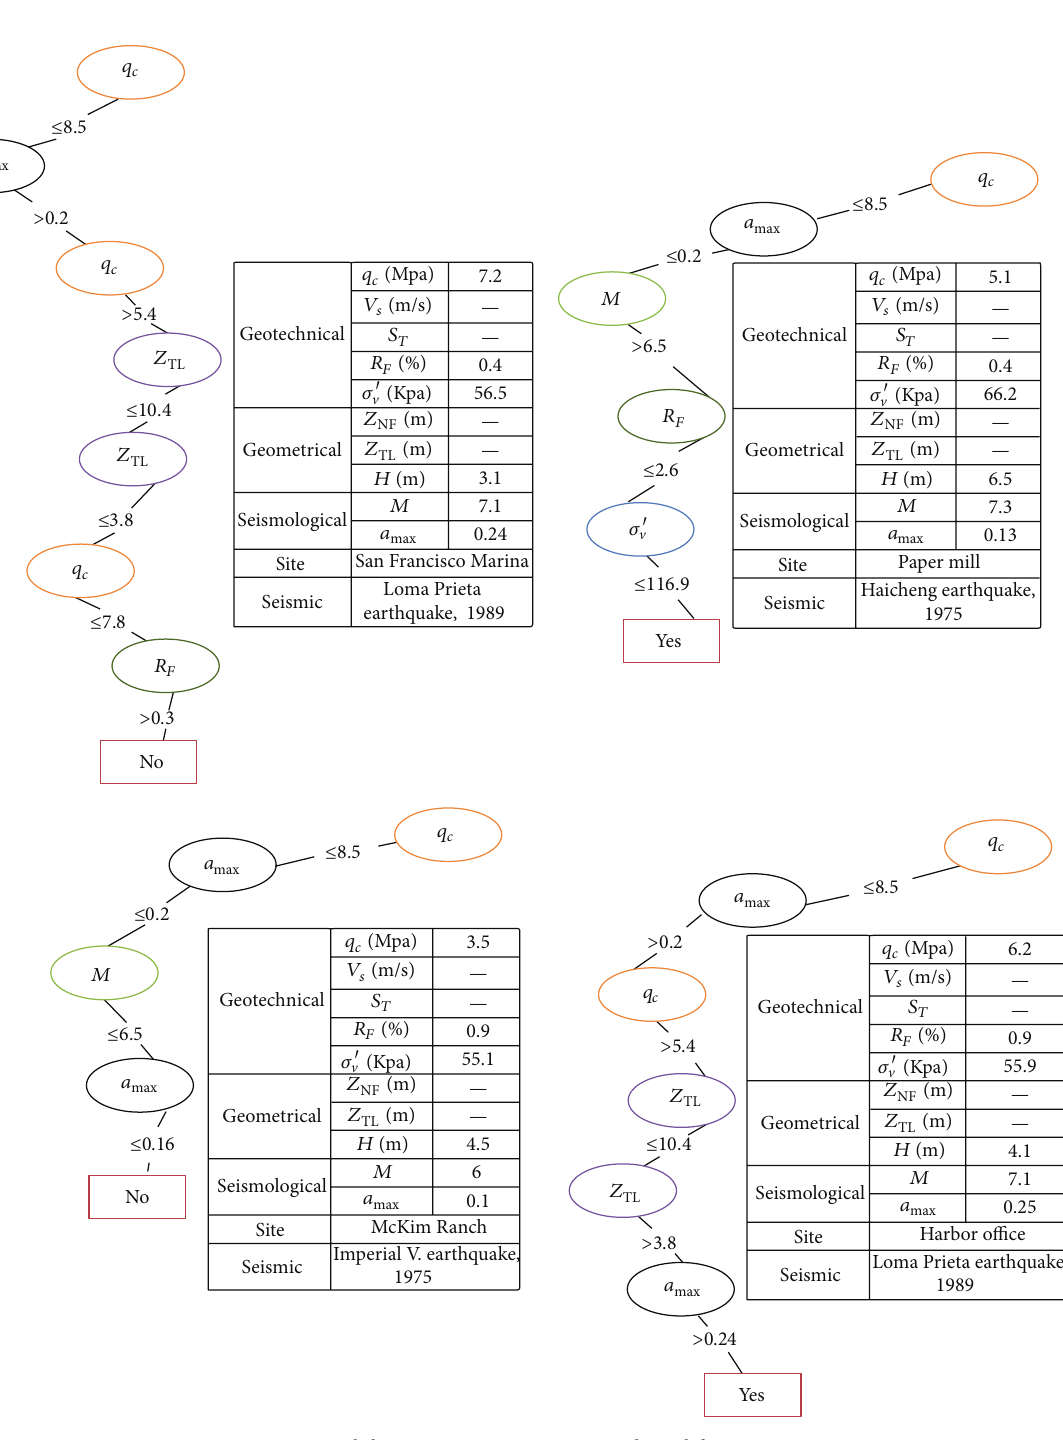
Figure 23: Validation tests: using 𝑞 𝑐 as geotechnical